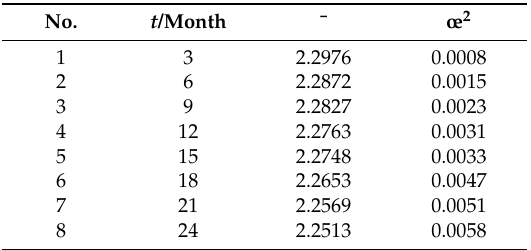
Table 4. Characteristic parameters of maximum